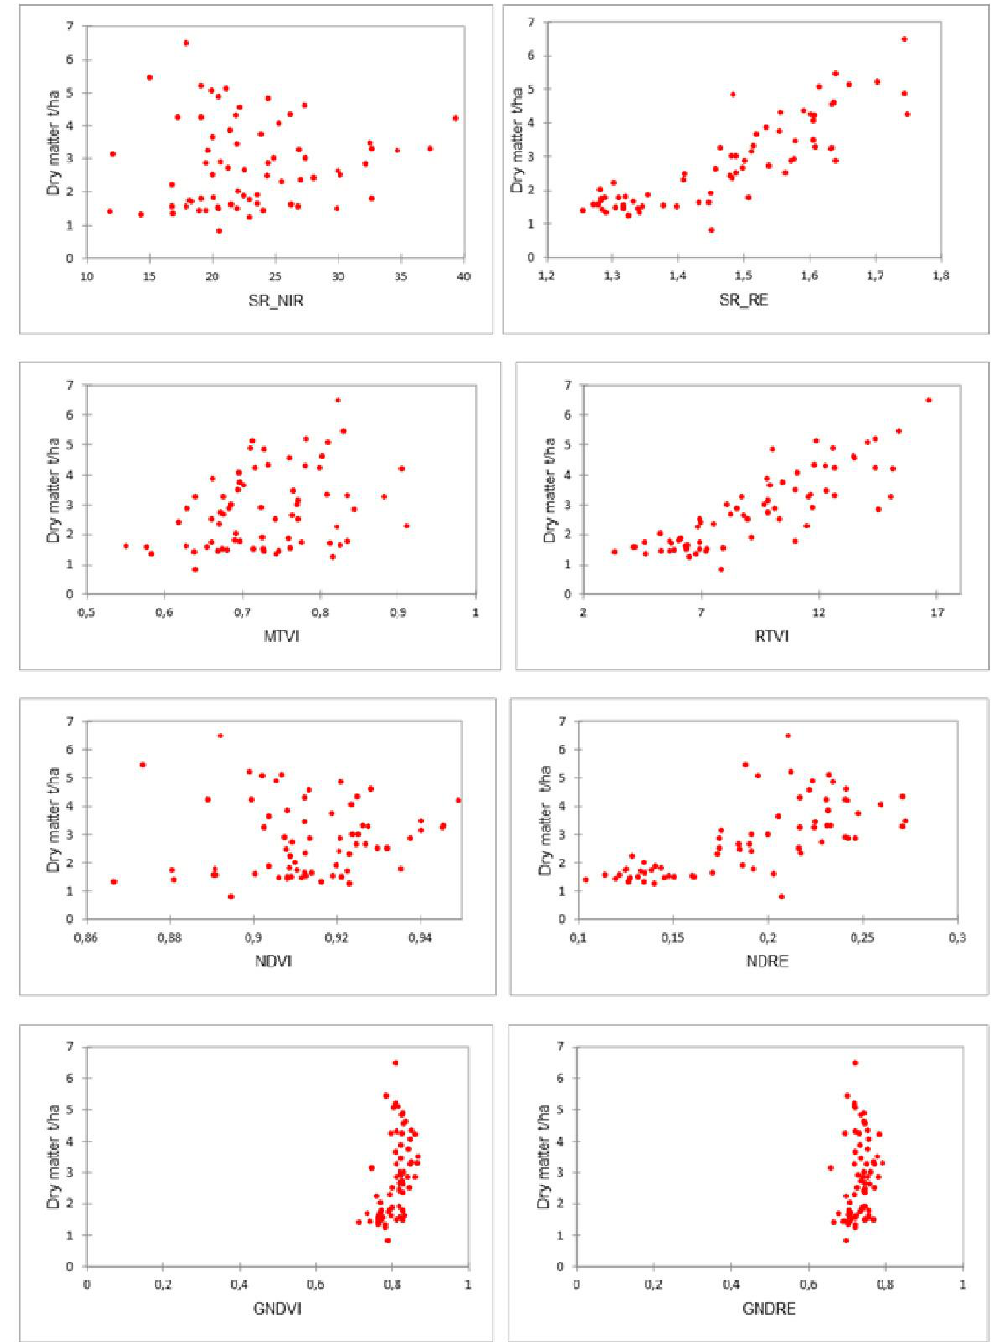
Figure 10. Variation of dry matter by each vegetation